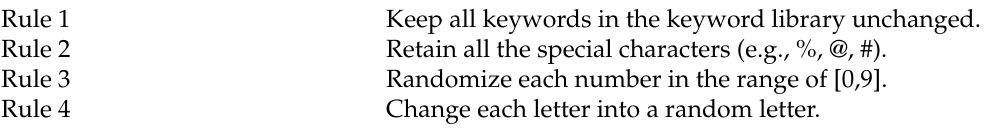
Table 1. The rules of payload perturbation. Keep all keywords in the keyword library